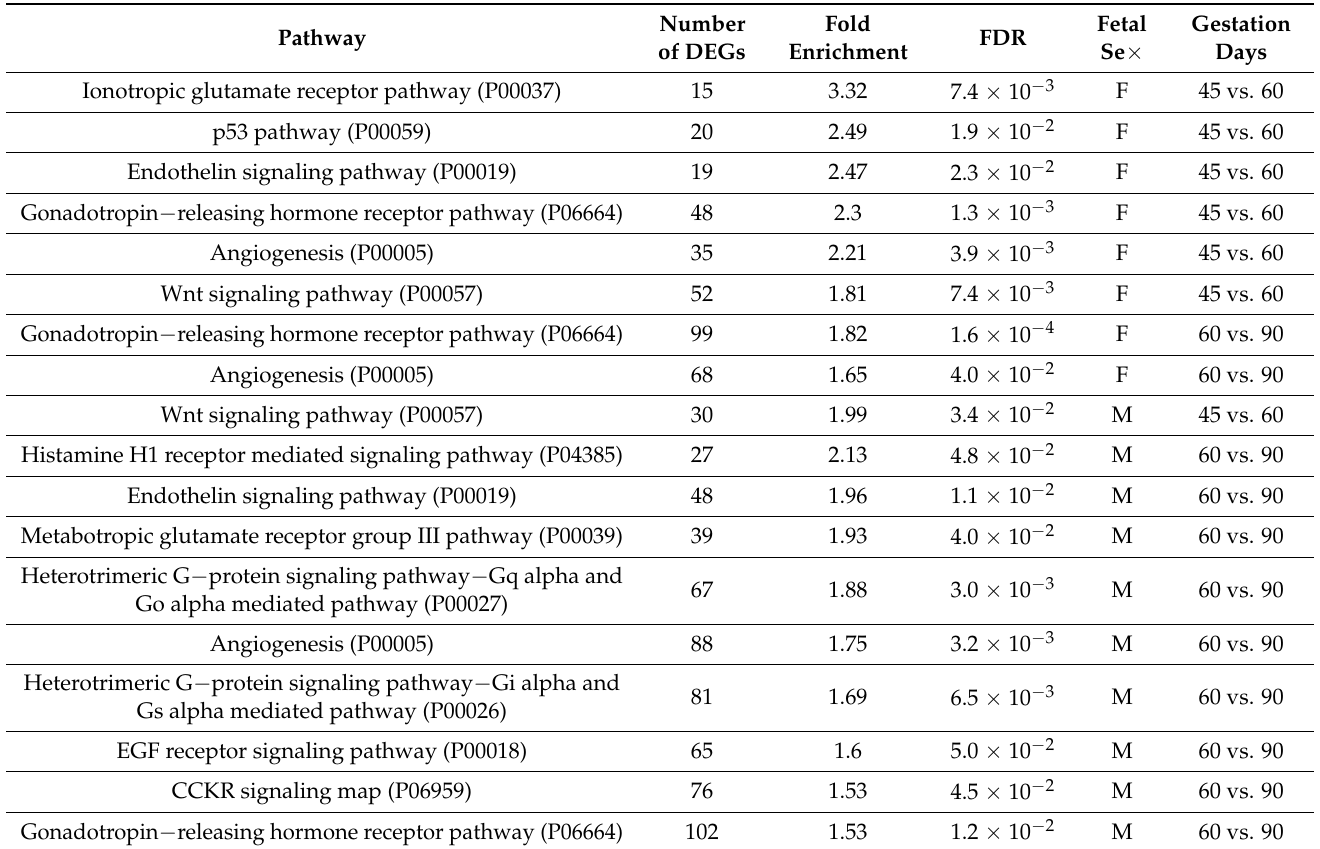
Fetal Gestation Number Fold FDR Se × Days of DEGs Enrichment